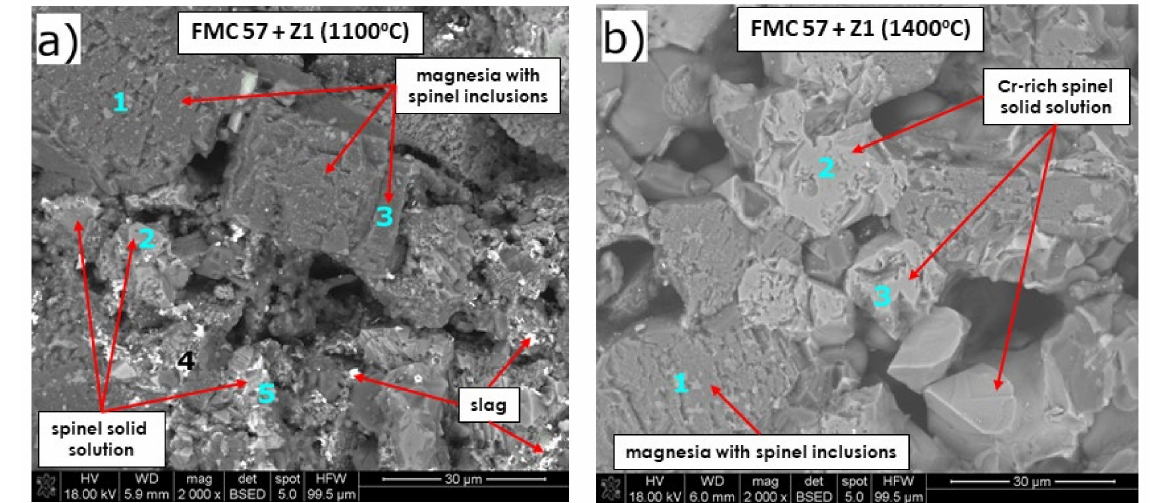
Figure 8. SEM images of magnesia–chromite co-clinker FMC 57 after pellet test at ( a ) 1100 ◦ C and